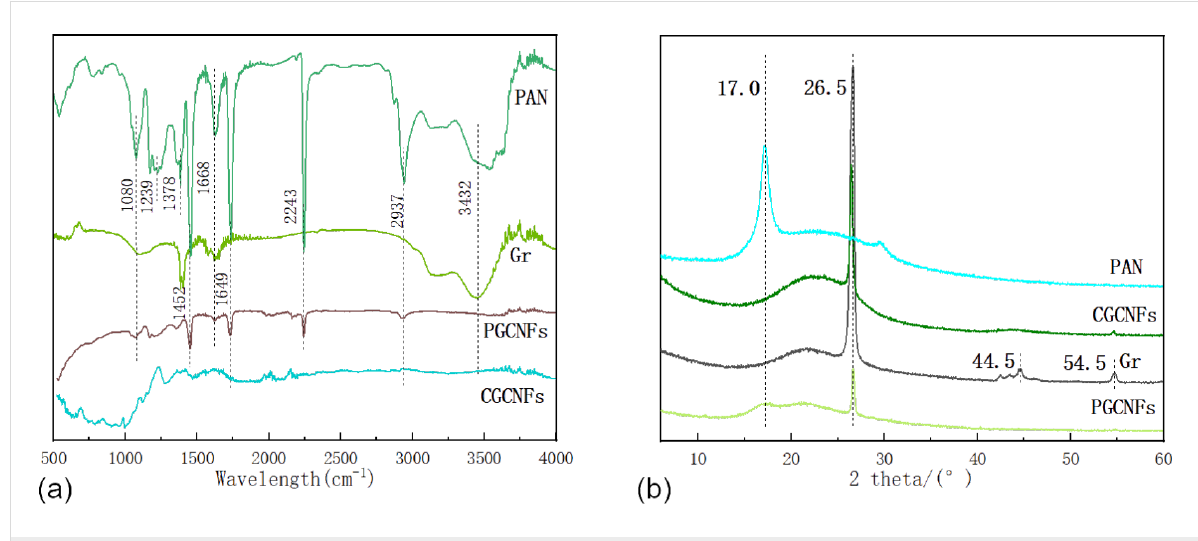
Figure 3: (a) FTIR spectra of PAN nanofibers (dark green), graphene (light green), PGCNFs (purple) and CGCNFs (cyan). (b) XRD results of PAN nanofibers (cyan), graphene (gray), PGCNFs (light green) and CGCNFs (dark